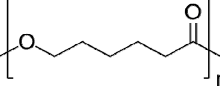
Figure 11. Chemical structure of ( A ) PCLa [117] and ( B ) PEO [118].